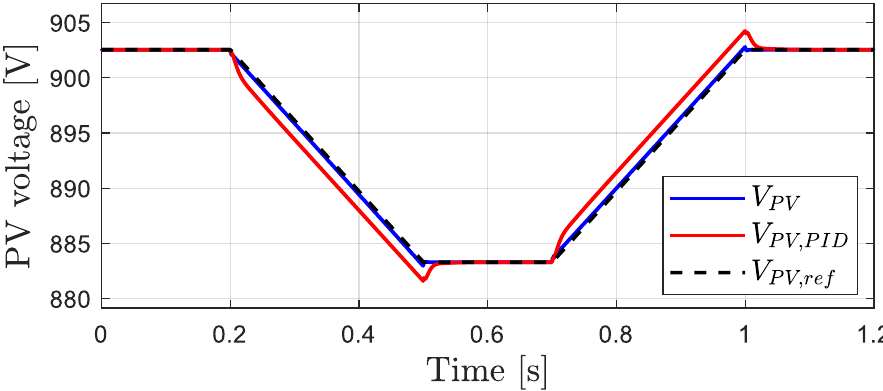
Figure 10. PV voltage time profile comparison.